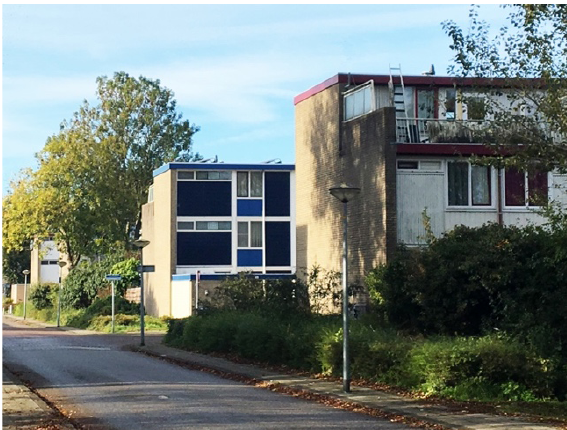
Figure 11. Atolwijk: view of ‘piano’ houses. Source: